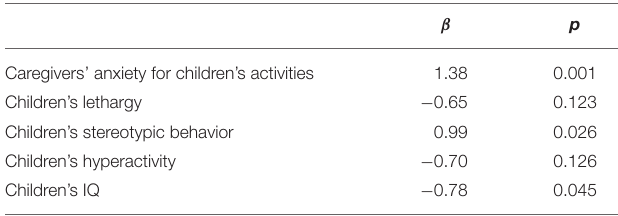
TABLE 5 | The result of the step-wise regression analysis on children’s depressive